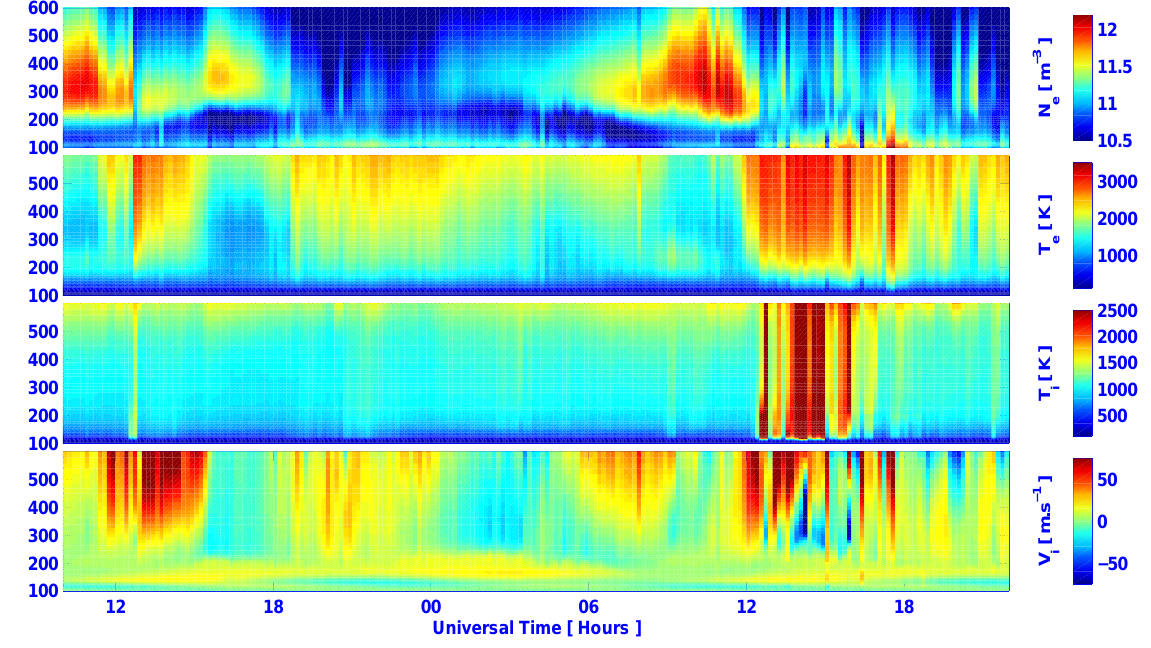
Fig. 7. From top to bottom: Time/altitude color plot of the electron concentration (Log 10 scale), the electron temperature, the ion temperature and the line of sight ion velocity, from TRANSCAR simulation, for the same period as Fig.